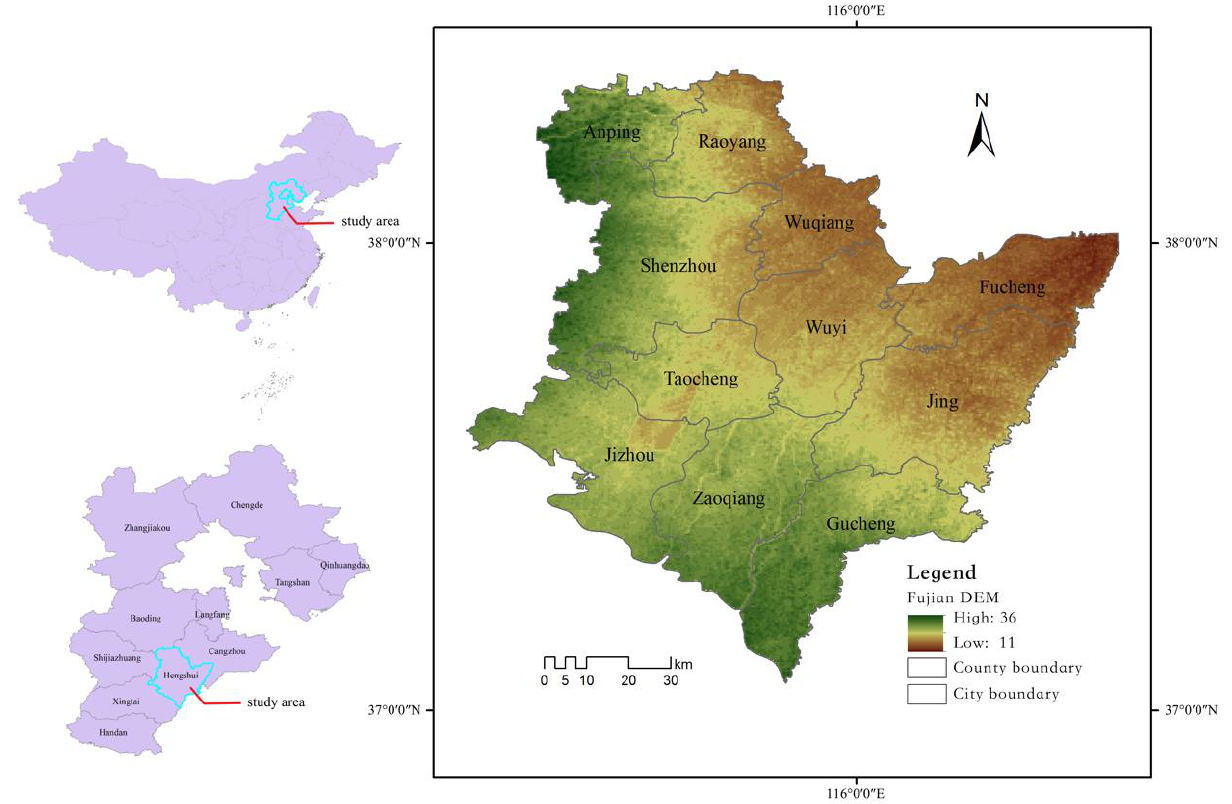
Figure 1. Geographic location map of Hengshui city.